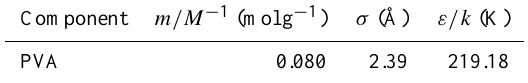
Table A1. Pure-component PC-SAFT parameters for PVA.